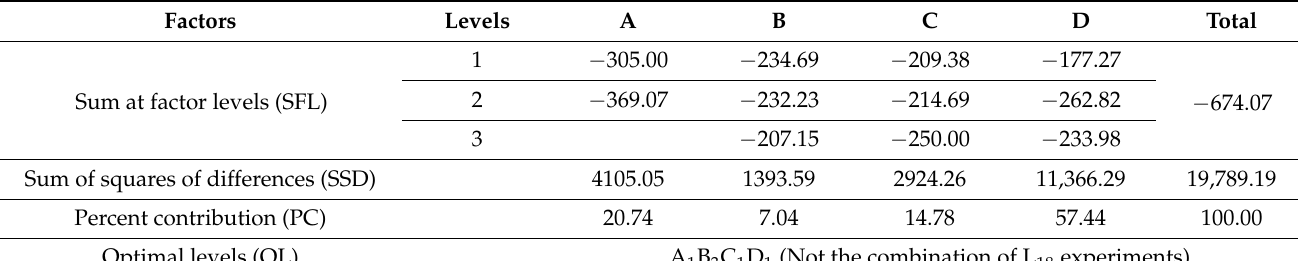
Table 8. Pareto ANOVA results for material removal rate (MRR).